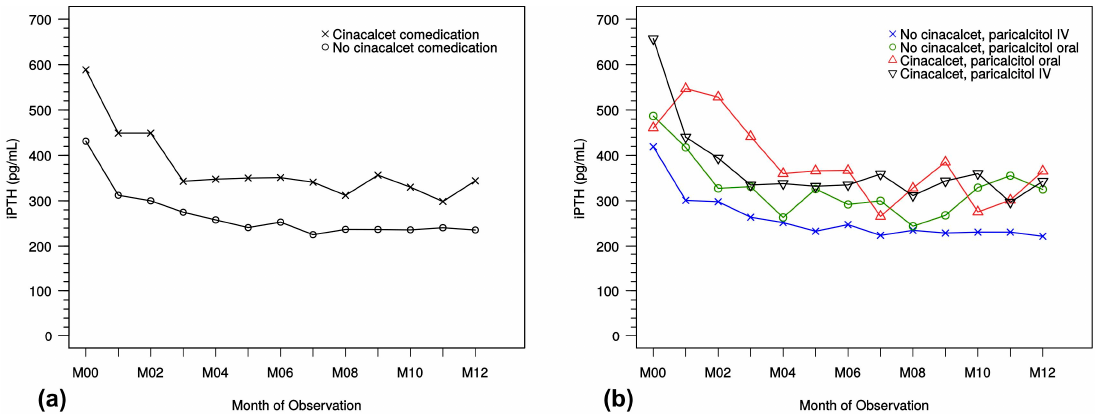
Figure 6. ( a ) Course of iPTH in dialysis patients with and without cinacalcet co-medication; ( b )